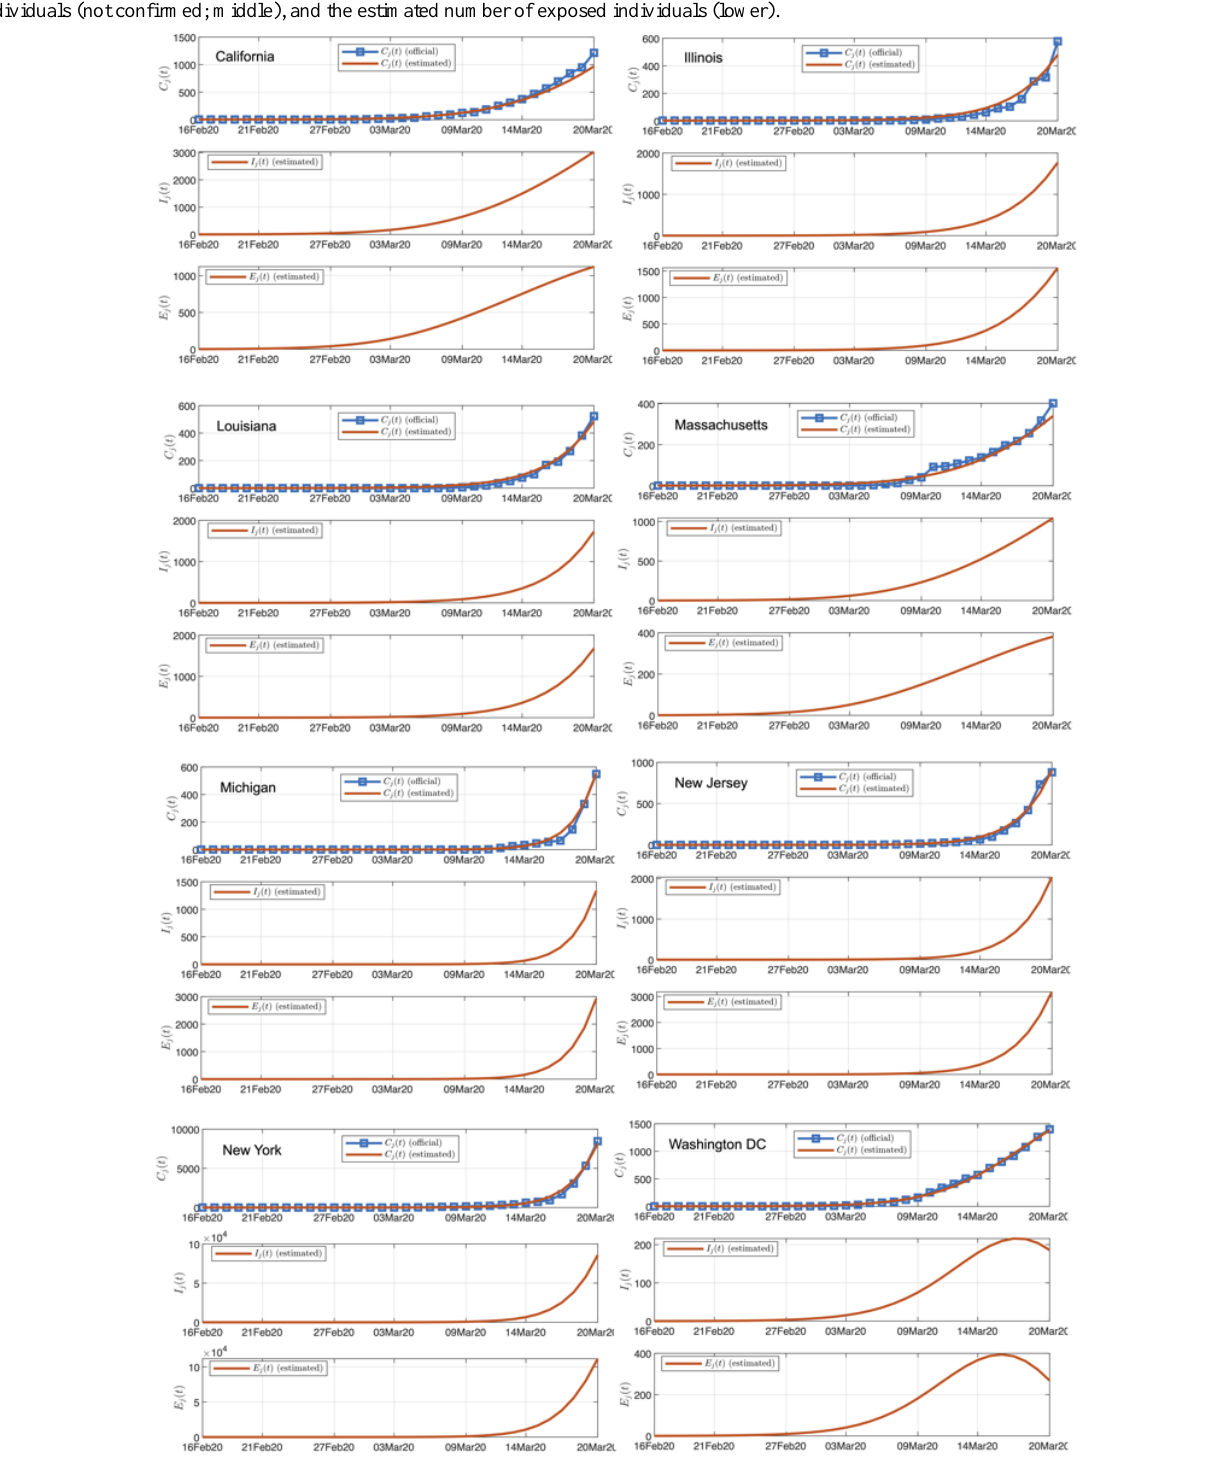
Figure 4. Official and estimated number of infected individuals in 8 selected states in the United States (upper), the estimated number of infected individuals (not confirmed; middle), and the estimated number of exposed individuals